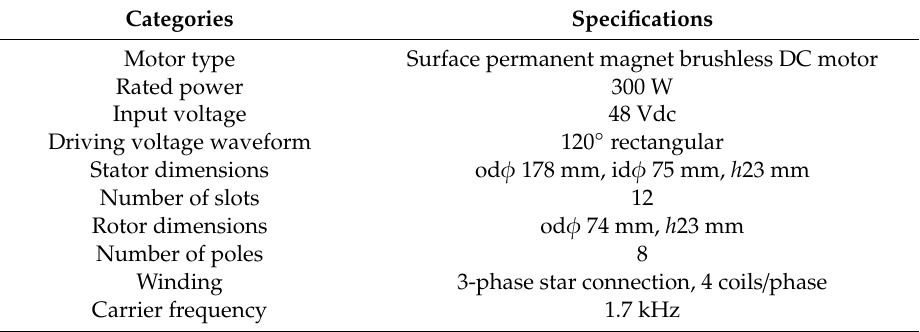
Table 1. Specification of tested